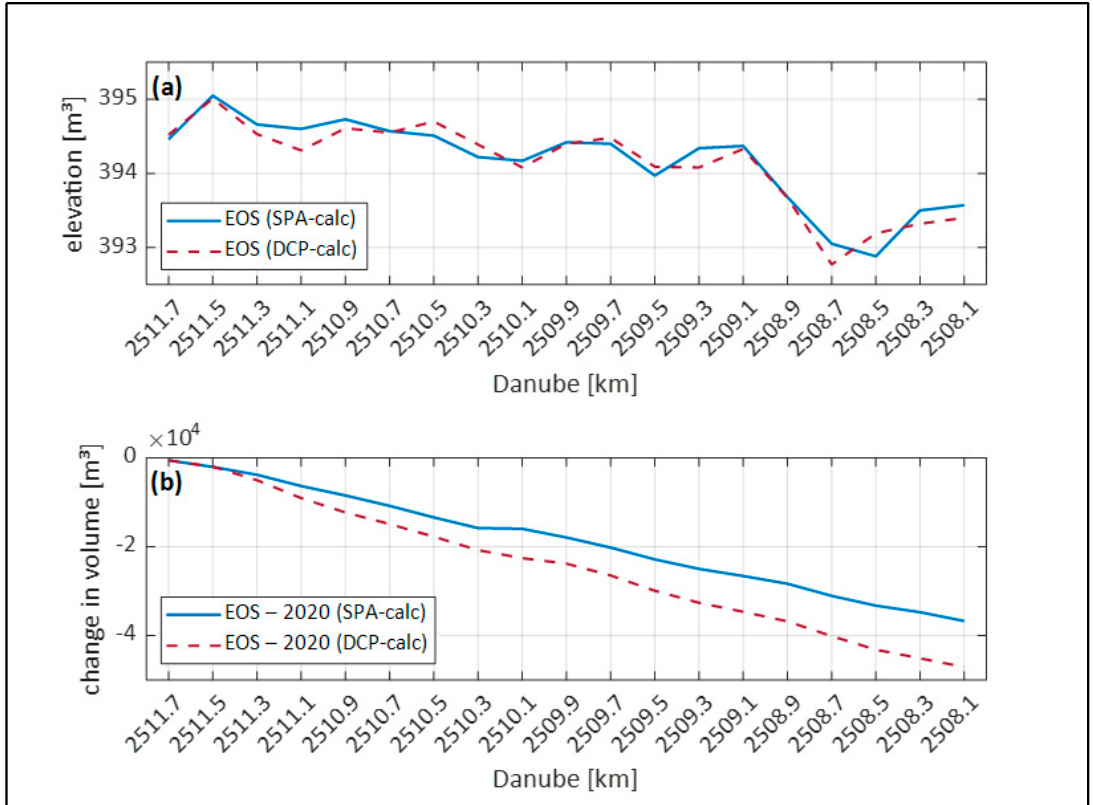
Figure 7. Elevation at the end of simulation (EOS) as simulated by spatial (SPA-calc) and derived cross-profile (DCP-calc) data ( a ) and the cumulative change in volume for SPA and DCP simulations ( b ).